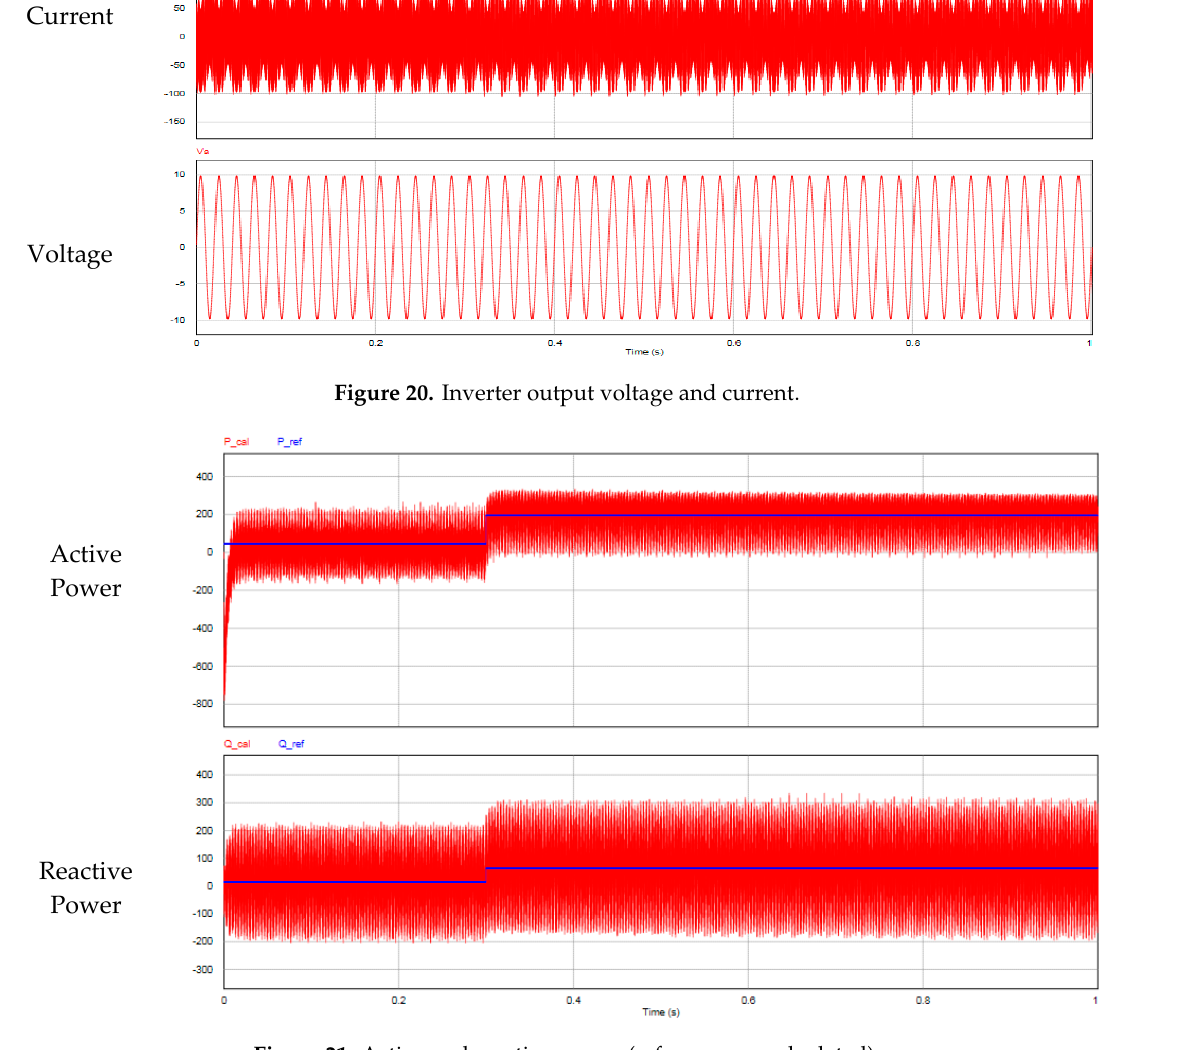
Figure 21. Active and reactive power (reference vs. calculated).